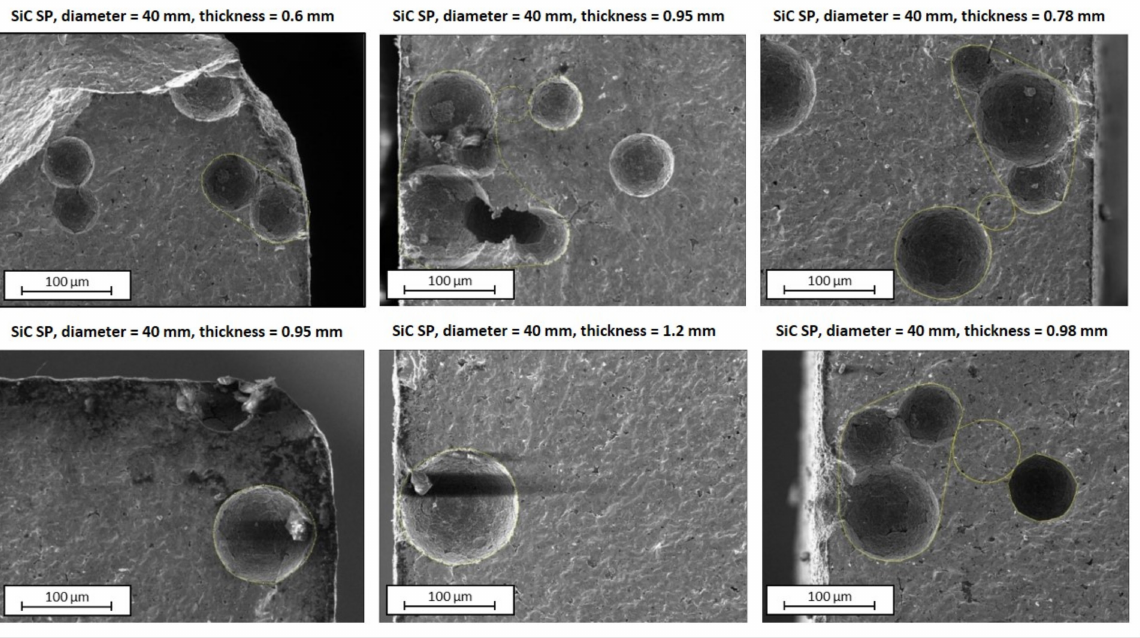
Figure 8. SEM images of the fracture surface in proximity of the disc periphery for six different SiC SP test